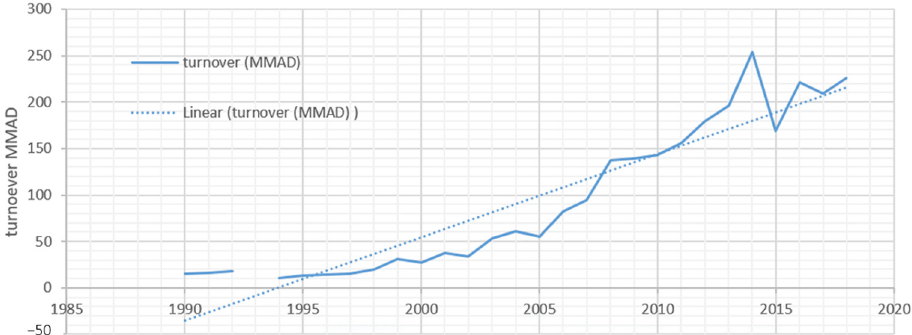
Figure 5. Turnover evolution (solar thermal Moroccan market) for 3500 MAD/m 2 . [42] .